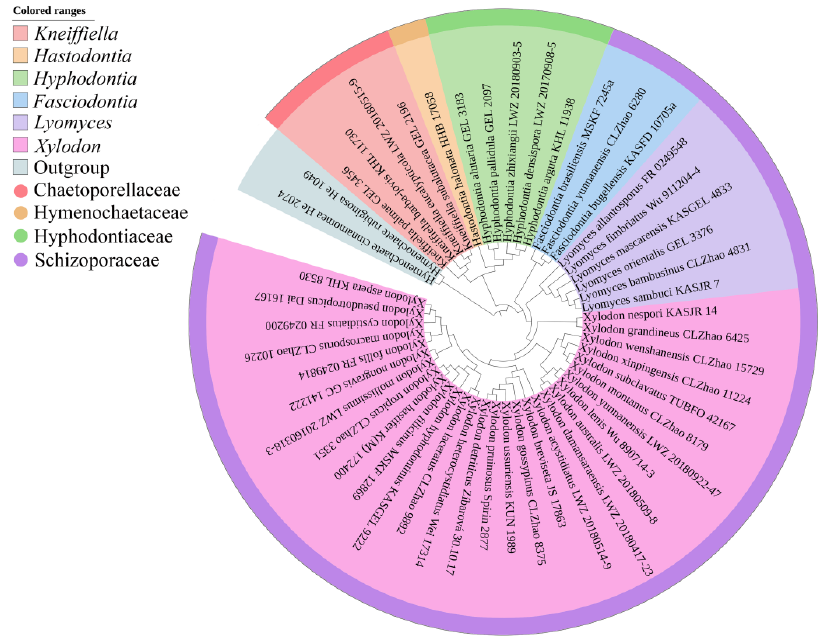
Figure 1. Maximum parsimony strict consensus tree illustrating the phylogeny of Xylodon and related genera in the order Hymenochaetales based on ITS+nLSU sequences. The families and genera represented by each color are indicated in the upper left of the phylogenetic tree.